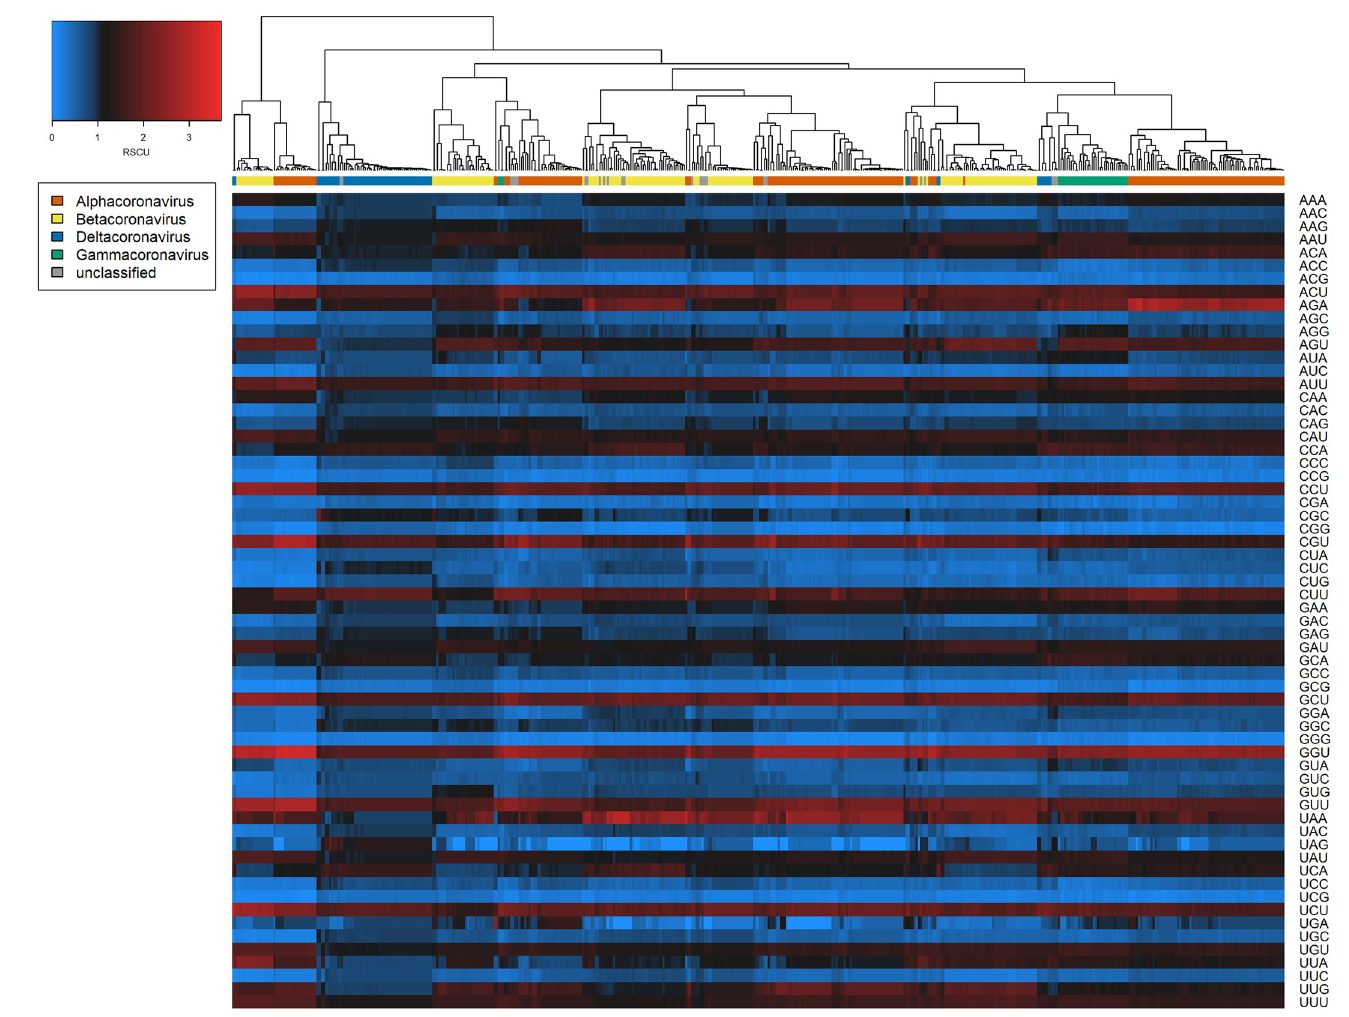
Fig 2. Codon biases (RSCU) across coronavirus whole genome sequences examined. Heatmaps of coronavirus codon usage bias (RSCU) associated with each codon in each whole genome sequence (n = 511). Main colour scale denotes RSCU value, a null value of 1 (black) indicating no difference in codon usage from expectation, with blue and red representing under- or overrepresentation respectively. Dendrogram colour bar denotes taxonomic genus.